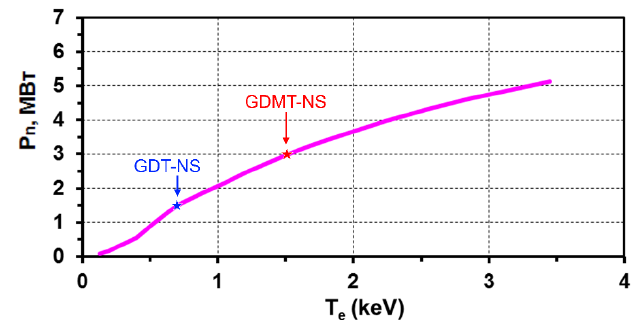
Figure 5. Fusion neutron power vs. electron temperature for the GDT ‐ based neutron source with 40 MW 65 keV neutral beam injection. Stars correspond to GDT ‐ NS and GDMT ‐ NS